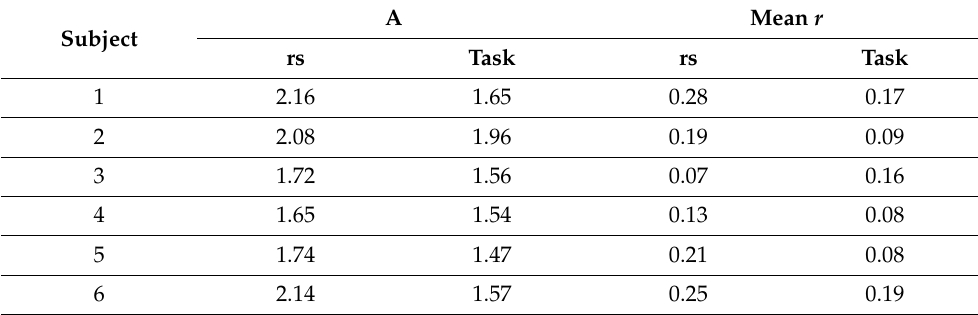
Table 1. The quantified value of a in Equation (6) and the computed value of the mean r in Equation (5) for each brain state of each subject. rs: resting-state; SD: standard deviation.